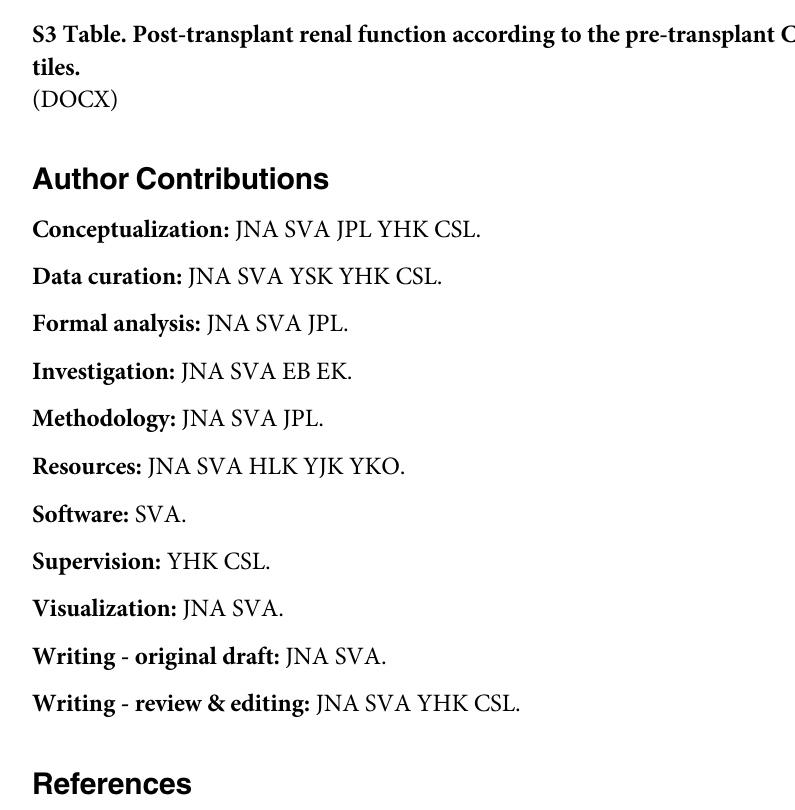
S1 Table. The clinical outcomes after kidney transplantation. S2 Table. Post-transplant renal function according to the presence of pre-transplant vascu- lar disease. S3 Table. Post-transplant renal function according to the pre-transplant CV risk score ter-